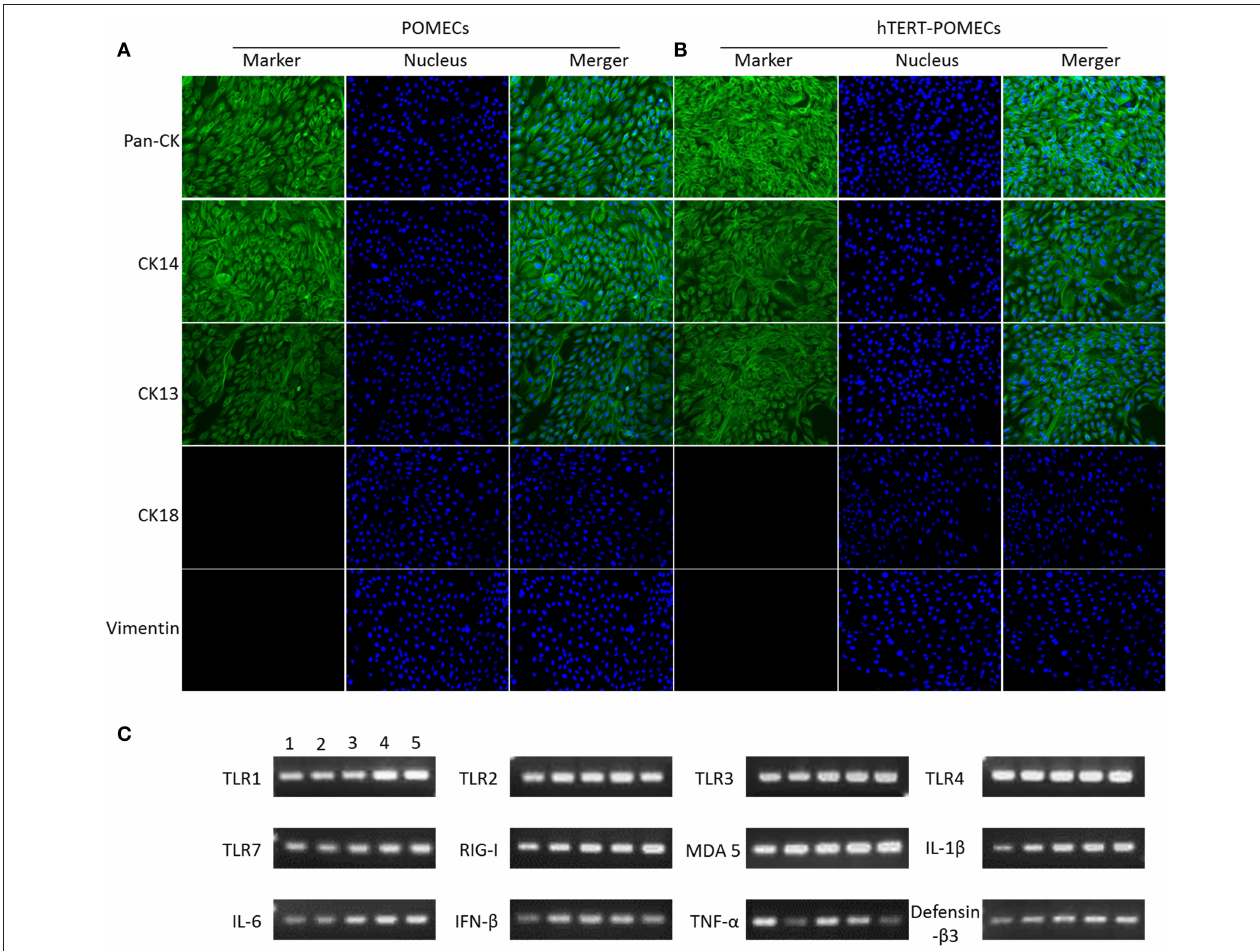
FIGURE 2 | Identification of primary POMECs and hTERT-POMECs. (A,B) Immunofluorescence identification. Third passage POMECs and 80th passage hTERT-POMECs were stained with pan-cytokeratin, cytokeratin 14, cytokeratin 13, cytokeratin 18, or vimentin ( × 200 magnification). (C) Certain immune-related genes were detected qualitatively by RT-PCR in primary POMECs and hTERT-POMECs. Line1: third passage POMECs; Line 2–5: 30th, 50th, 80th, 100th passage hTERT-POMECs, respectively.